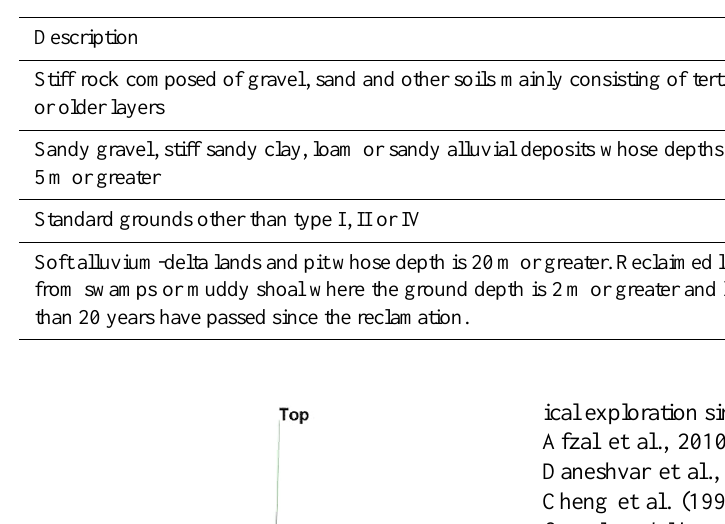
Table 2. Site effect classification of Nogoshi and Igarashi (1970).